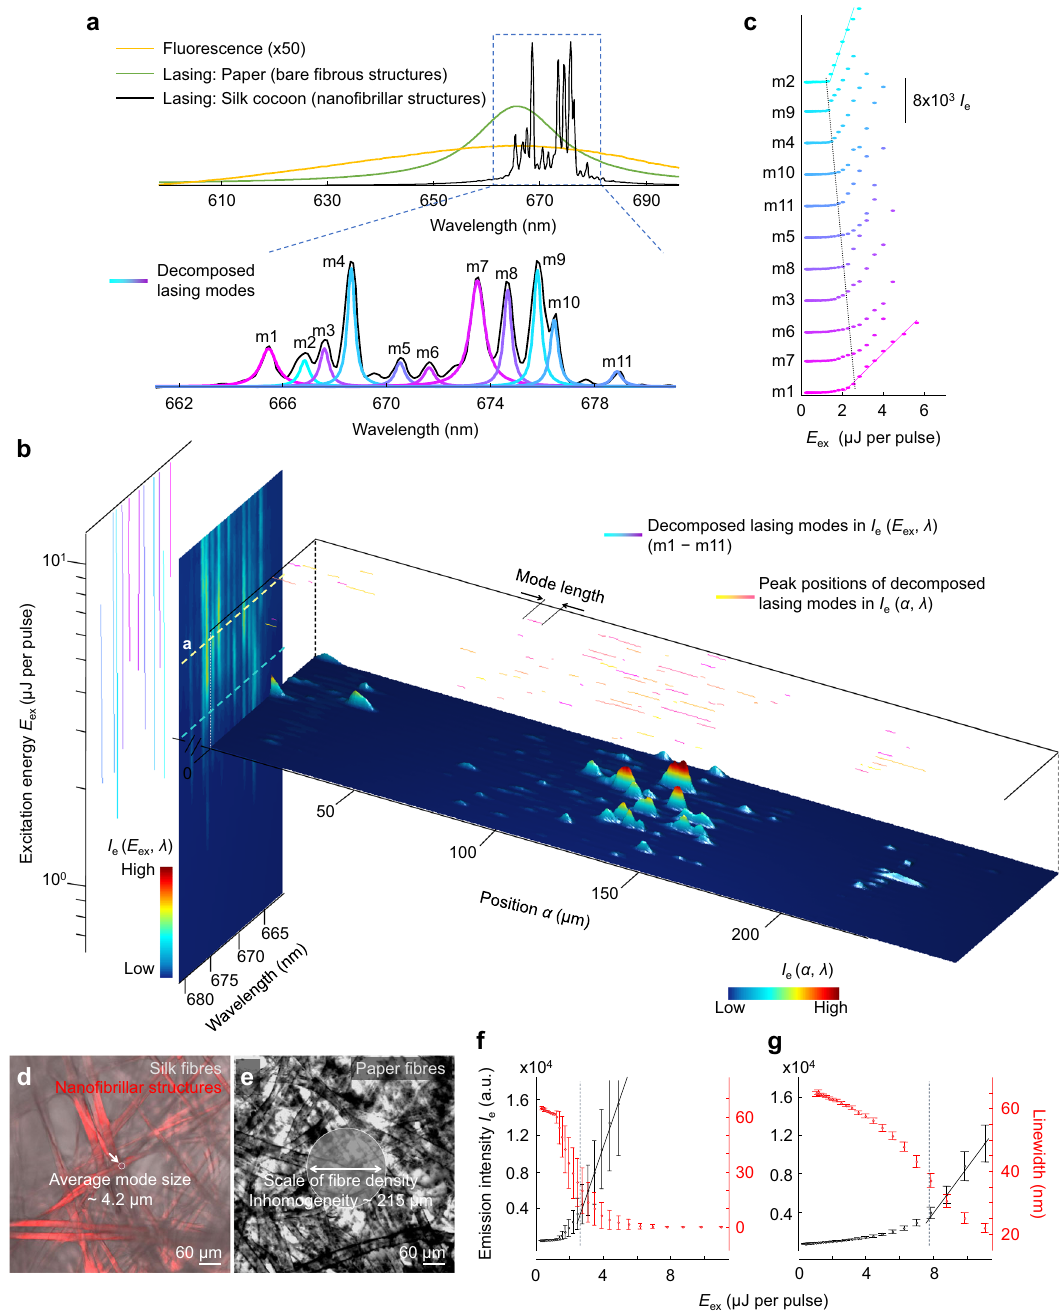
Fig. 5 Interrogation of localized modes by internal luminescence. a Modal decomposition (blue – magenta) of transmitted emission I e (grey line) in b by inversely estimating a h , ω h and Γ h in the analytical expression of Eq. (1). The modes (m1 – m11) are colour-coded with the thresholds plotted in c . b Space- energy wavelength spectrogram of emission I e ( r , E ex , λ ). Horizontal plane: I e ( r , λ ) near the gain – loss equilibrium ( = 3.5 µ J/pulse). r is the spatial coordinate on the input α – β plane (IP). λ h and Γ h are clearly identi fi ed over the position α (on IP), where the mode intensity is greater than the baseline. The λ h lines on the top (yellow – pink) delineate the spatial extent of modes. Vertical plane: I e ( E ex , λ ). The λ h lines on the left (blue – magenta) show suppression of modal interactions. c a h of single lasing modes decomposed in a as a function of E ex . The blue and magenta colours indicate the lowest and the highest threshold. d , e Average size of modes in silk d and average length scale of spatial intensity fl uctuations in paper e , overlaid on confocal microscopy images. f , g Average intensity and linewidth of the decomposed lasing modes in silk f and the diffusive lasing peaks in paper g as a function of E ex . The vertical yellow lines mark the average E ex , corresponding to the system gain – loss equilibrium. The error bars are the standard deviations of the intensity and linewidth from 259 lasing modes shown in Supplementary Fig.